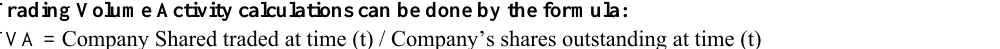
Table 3: Trading Volume Activity Formula